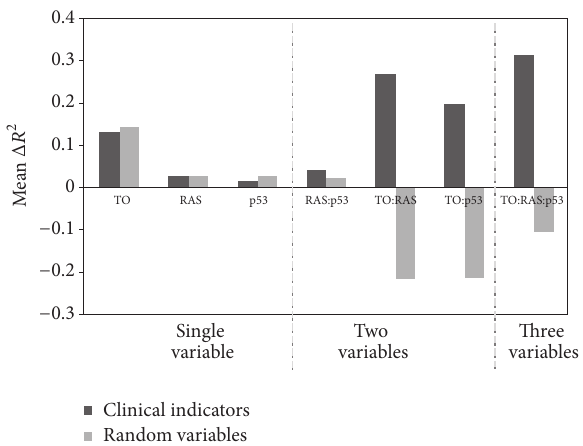
Figure 4: Change in Adj- 𝑅 2 values obtained by incorporating interaction terms in linear model for either biological indicators or random variables. Linear models were created for each gene, incorporating the three biological indicators. Differences in Adj- 𝑅 2 values were computed for each experiment between using an additive model and an interaction-based model. The mean difference in 𝑅 2 was recorded when adding interactions terms to the individual linear